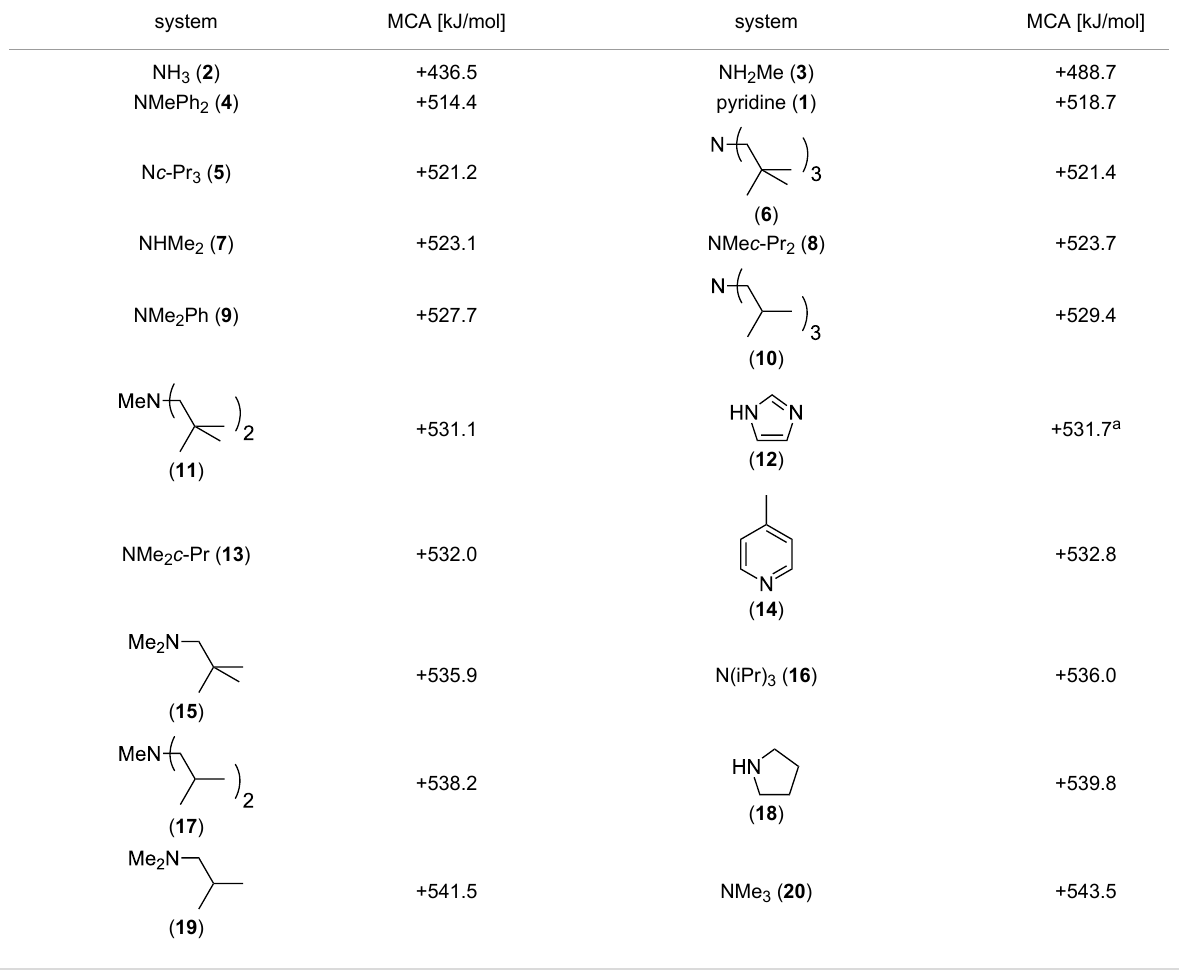
Table 1: MCA values for N-centered Lewis bases, ordered by increasing MCA